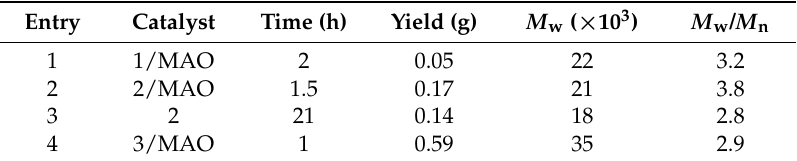
Table 3. Polymerization of 1,2-propadiene with cobalt complexes 1 – 3 a .